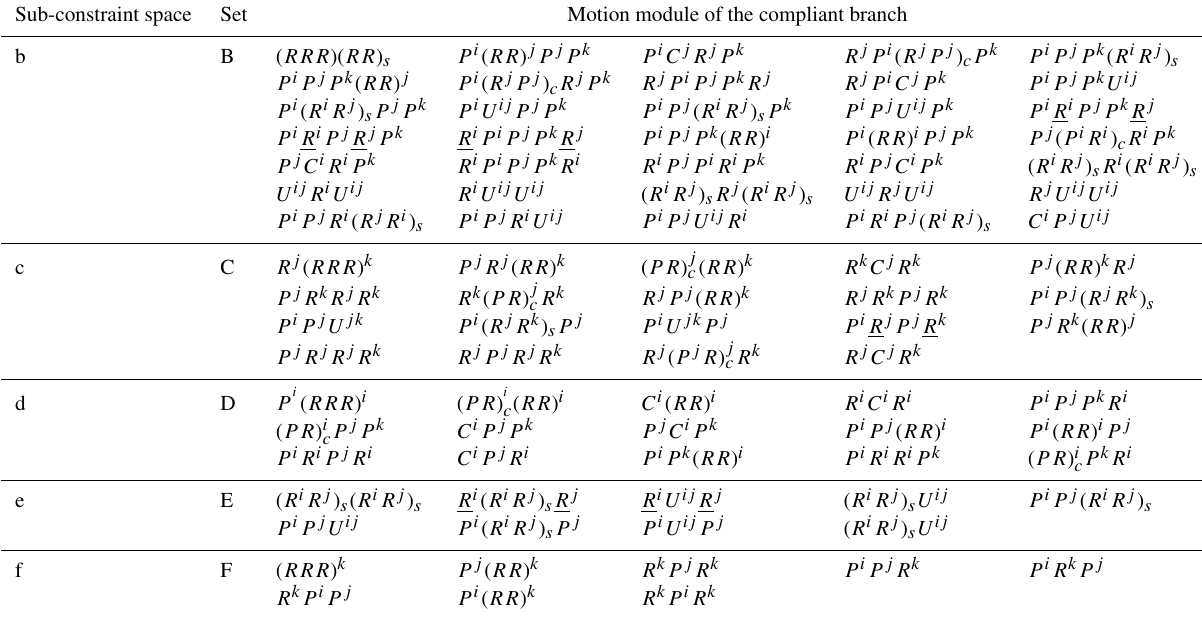
Table 5. The motion modules of the compliant branch under the different constraint case. Sub-constraint space Set Motion module of the compliant